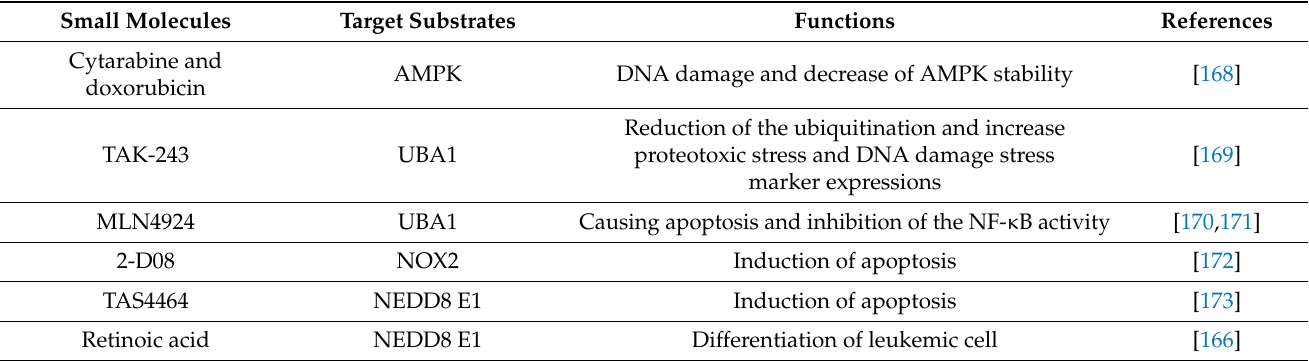
Table 6. AML-related small molecules, and their target substrates and functions. Small